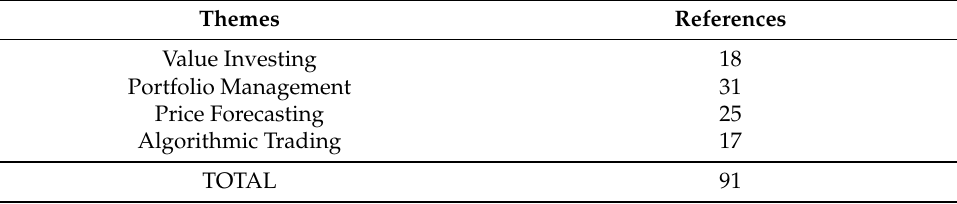
Table 2. Recurring themes and reference count from the literature